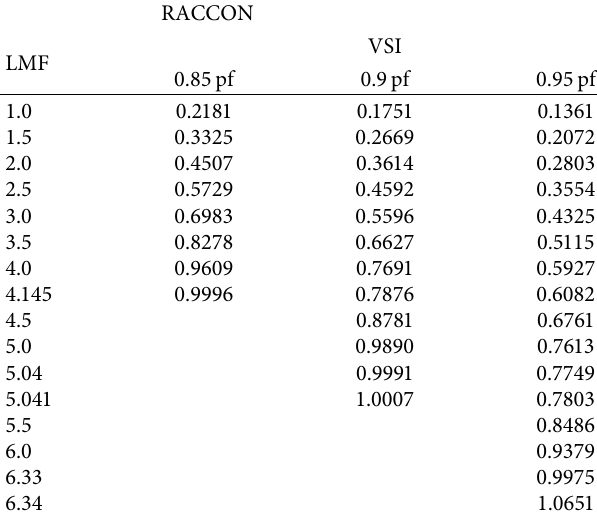
Table 3: Results of stability point of the RACCON